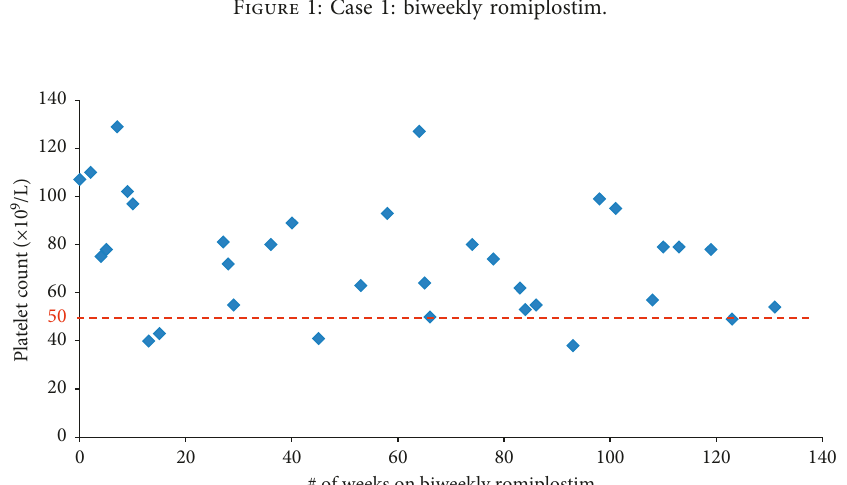
Figure 1: Case 1: biweekly romiplostim.